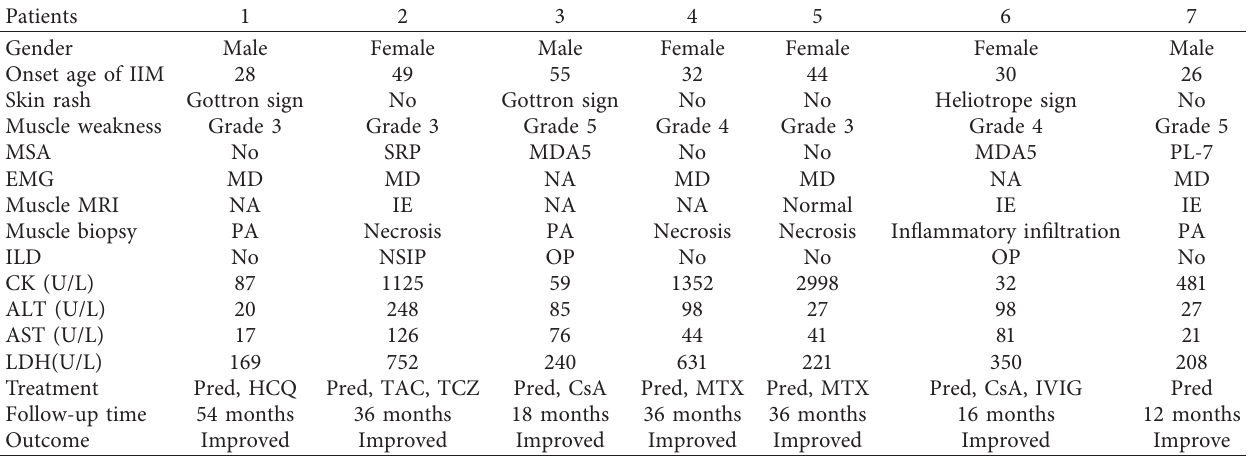
Table 2: Clinical symptoms, findings, laboratory test results, and treatment of IIM